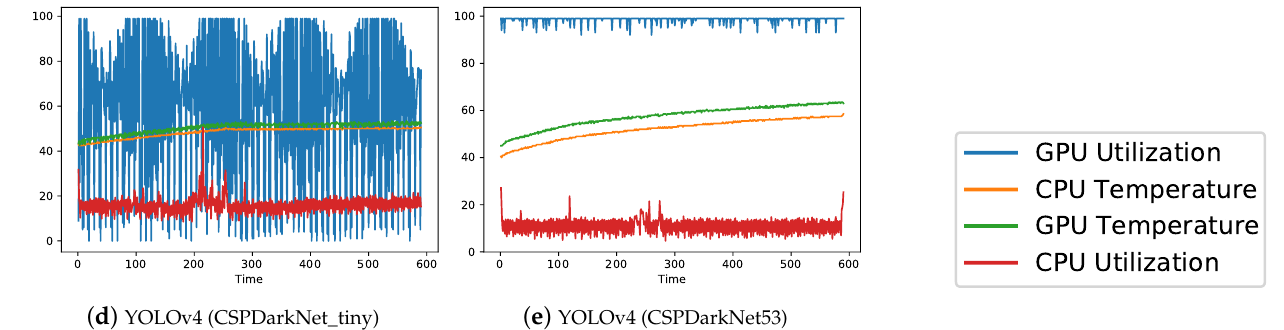
Figure 11. NVIDIA Jetson TX2 System usage plots for different variants of implemented computer vision object detection